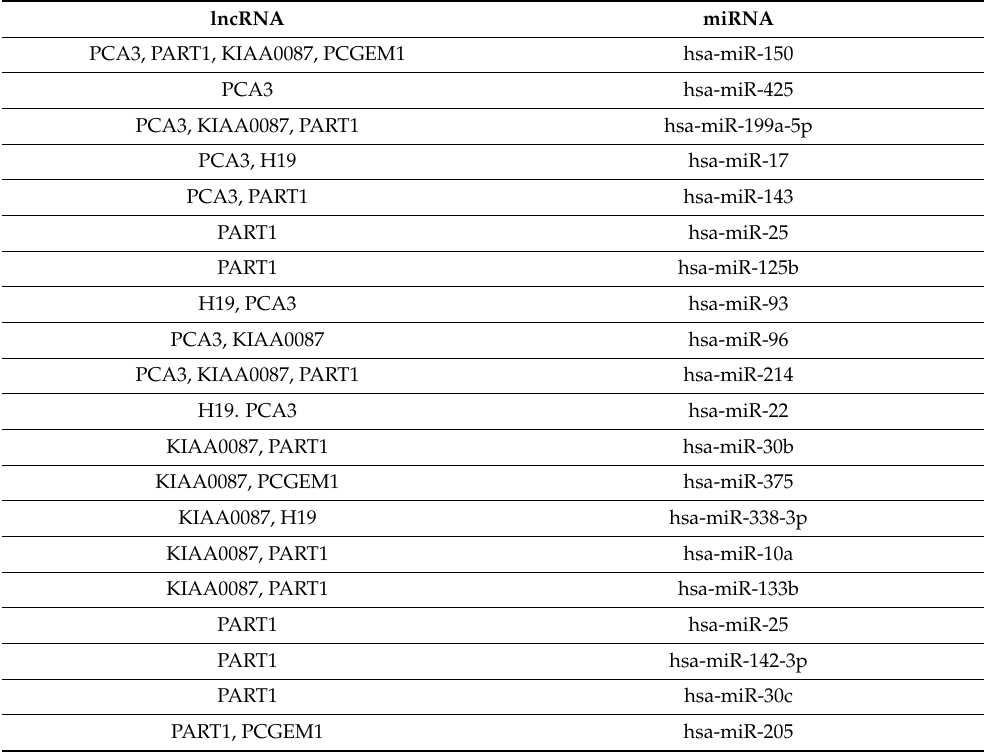
Table 7. The MiRcode database showed interactions between 5 DElncRNAs and 5 DEmiRNAs.